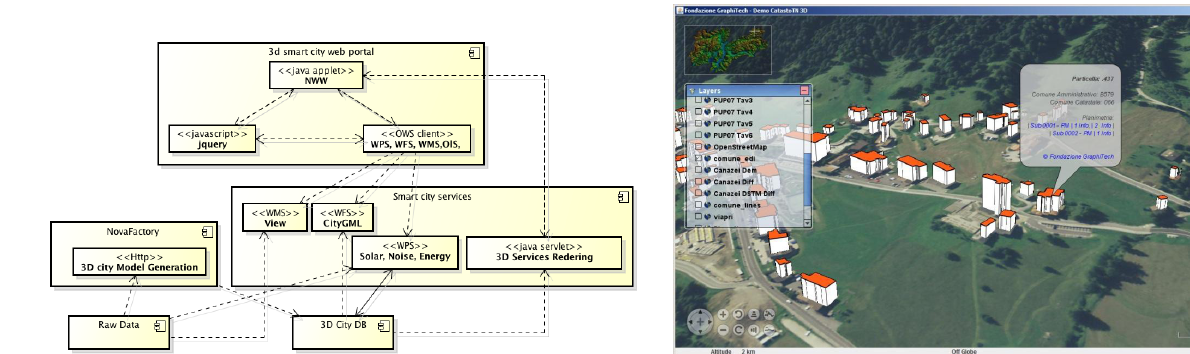
Figure 2 Service-oriented architecture of the smart city platform All these “ Raw Data ” are ingested on the smart city platform Databases to be provided to the final users as services or to be used at the middleware level in order to enrich the 3D city models (figure 3).